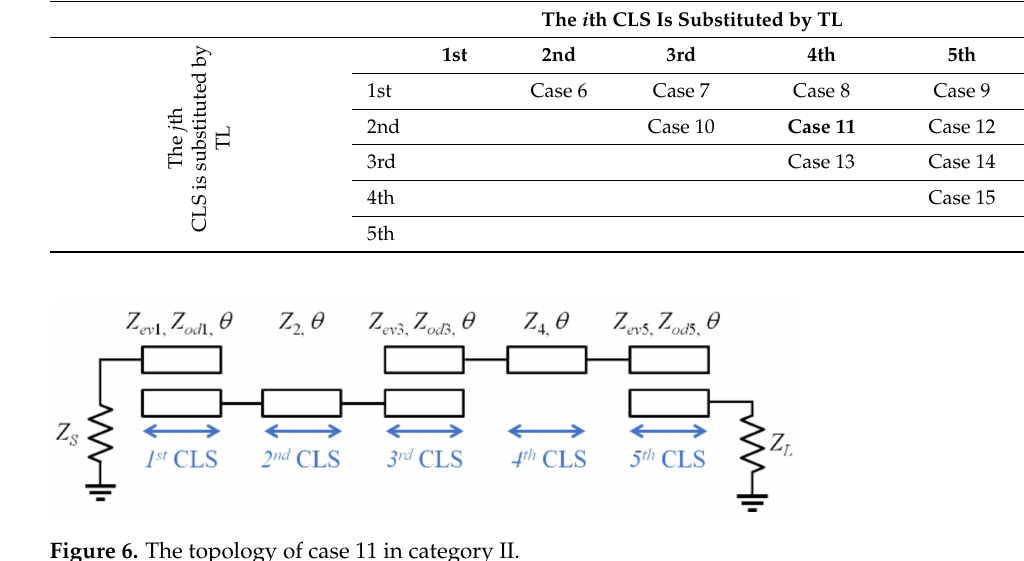
Figure 6. The topology of case 11 in category II.